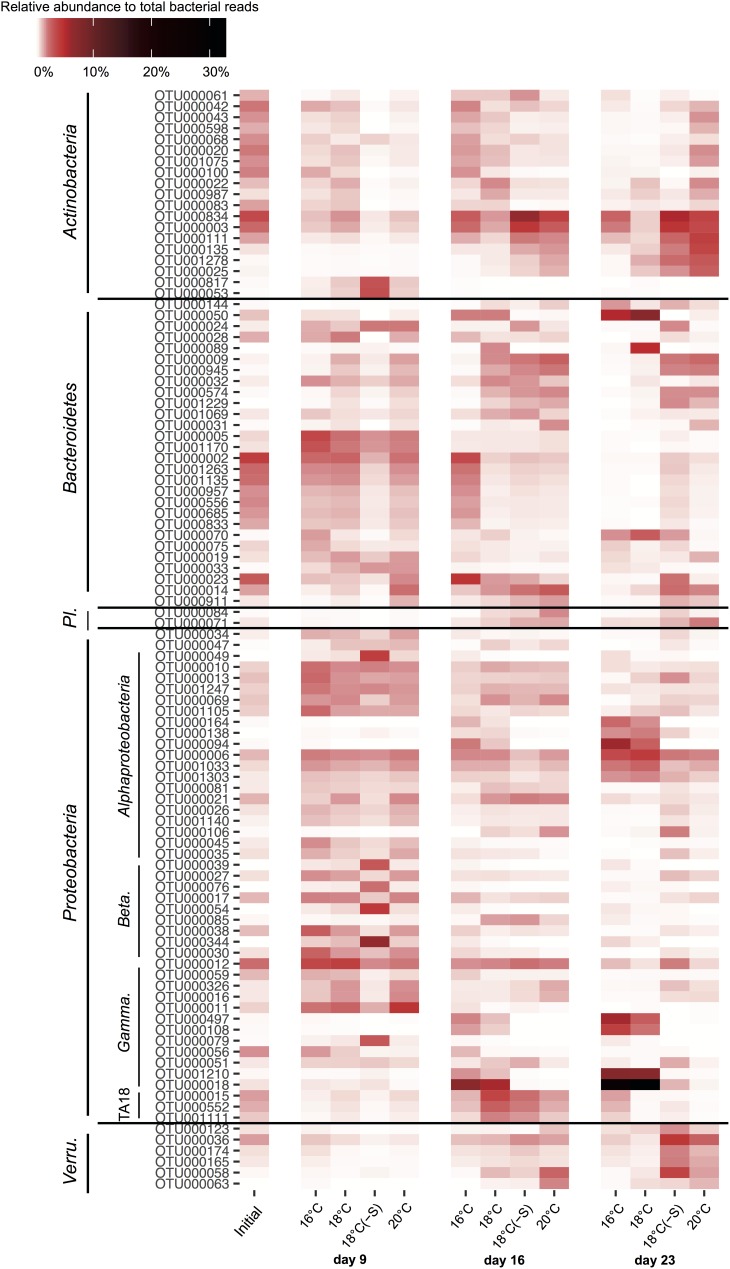
Dynamics of the 100 most abundant OTUs of heterotrophic bacteria during the experiment. The colors in the heatmap represent the averaged relative abundance of each OTU in a specific treatment and day (Initial n = 3; day 23 treatment 18°C(-S) n = 1; rest of the treatments and days n = 4). Abbreviations correspond to Planctomycetes (Pl.), Betaproteobacteria (Beta.), Gammaproteobacteria (Gamma.) and Verrucomicrobia (Verru.).